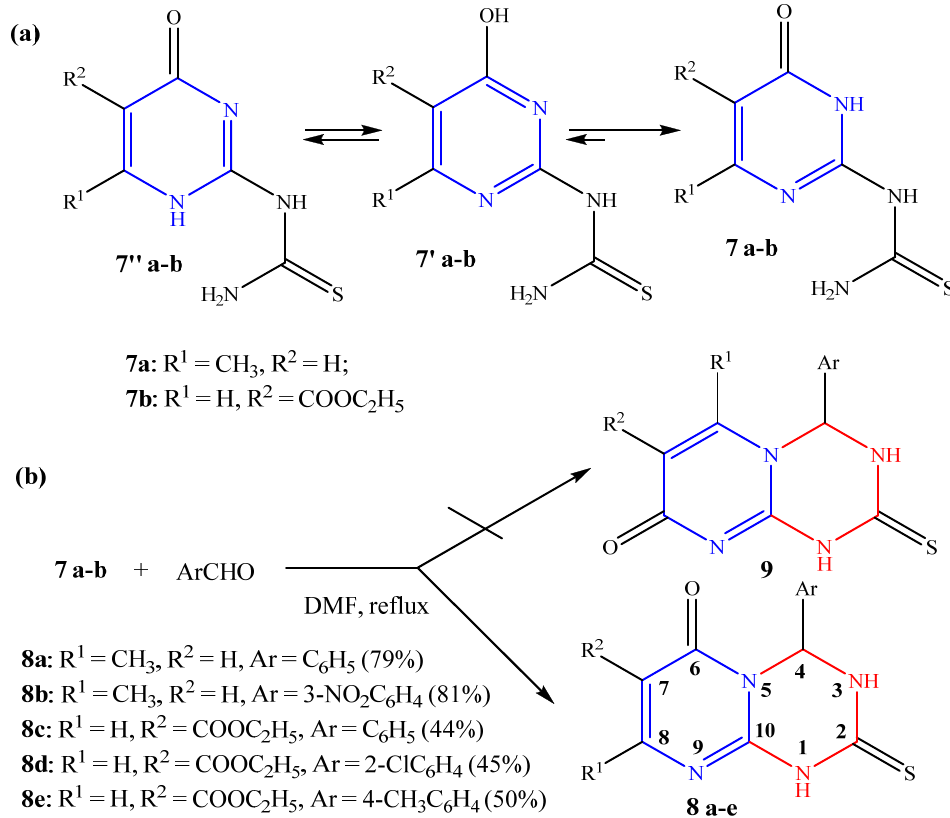
Figure 4. Tautomeric forms of 4-oxopyrimidin-2-ylthioureas 7a – b ( a ). Reaction of 4-oxopyrimidin-2- ylthioureas 7a – b with arylaldehydes ( b